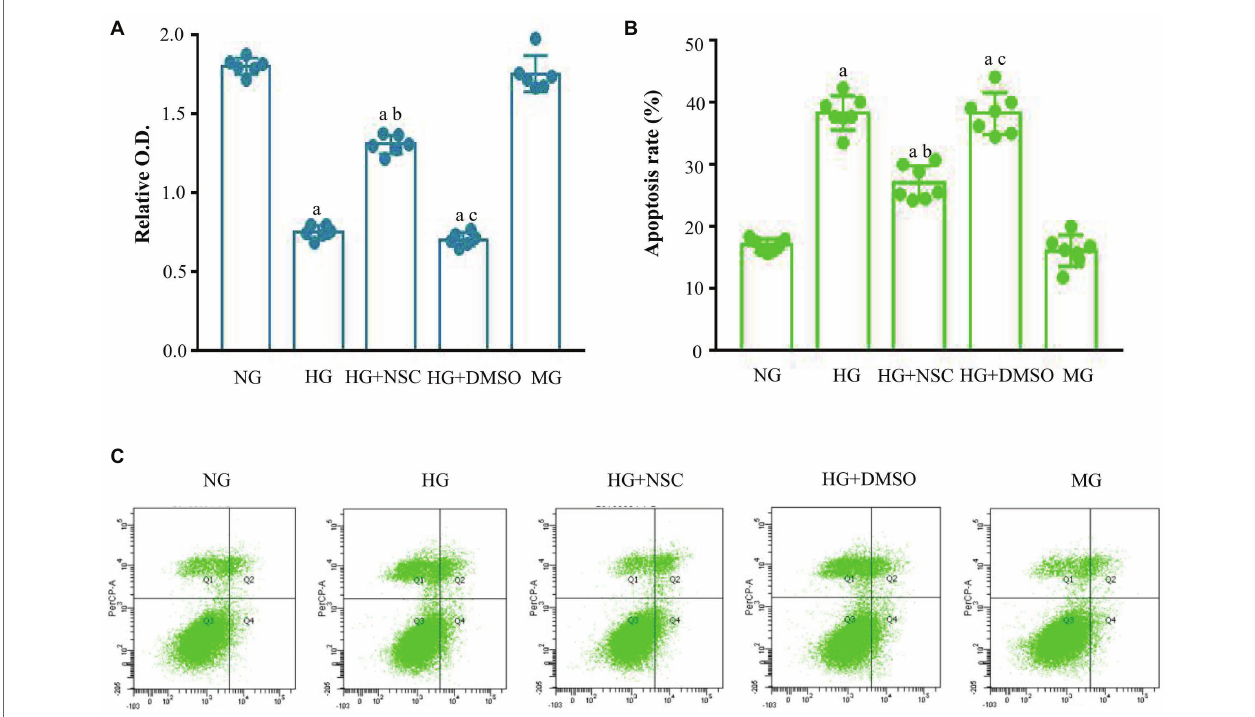
FIGURE 1 | Effect of Ras-related C3 botulinum toxin substrate 1 (RAC1) on cell proliferation and apoptosis. (A) Cells incubated in different conditions were analyzed using cell counting kit-8 (CCK-8). (B) Typical flow cytometry plots. (C) Analysis of cellular apoptosis rate. Data are shown as mean ± SD. a p < 0.05 vs. normal group (NG); b p < 0.05 vs. high glucose group (HG); c p < 0.05 vs. high glucose + RAC1 inhibitor group (HG + NSC). n = 7 in each